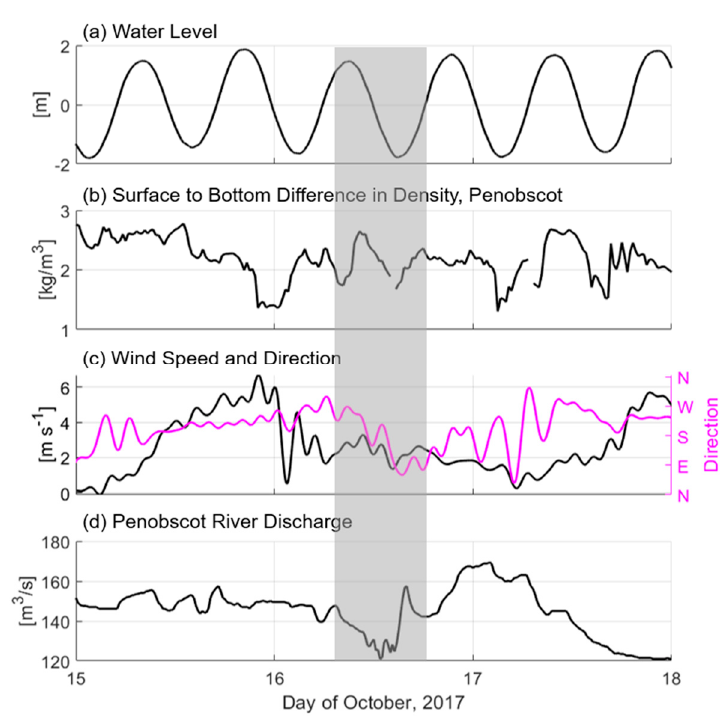
Figure 2. ( a ) Water level at Castine from mean sea level, ( b ) difference between bottom (25 m) and top (2 m) density anomalies at the Dice Head buoy, ( c ) wind speed [black] and wind direction [magenta] at Castine, and ( d ) Penobscot River discharge at West Enfield, ME. Sampling period is shaded in gray.